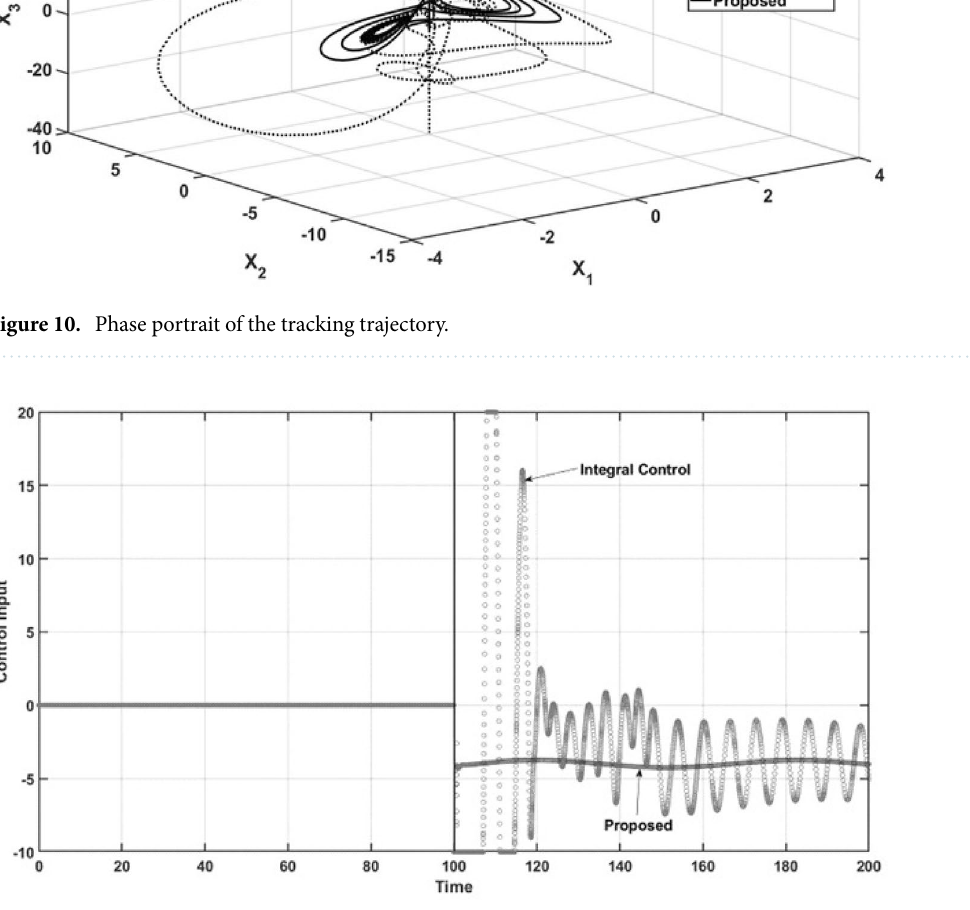
Figure 11. Control signals under the tracking